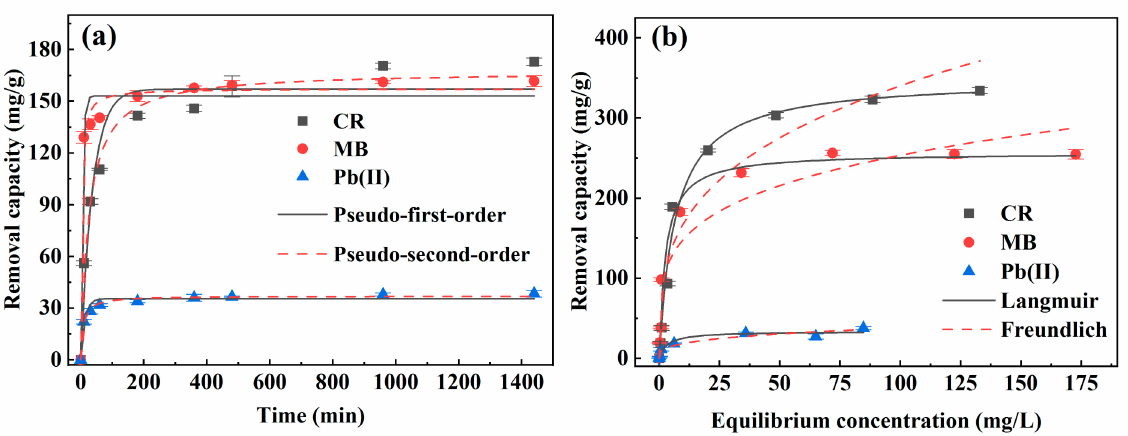
Figure 5. Adsorption kinetics ( a ) and isotherms ( b ) of single CR, MB and Pb(II) by the HC–MgAlLDH